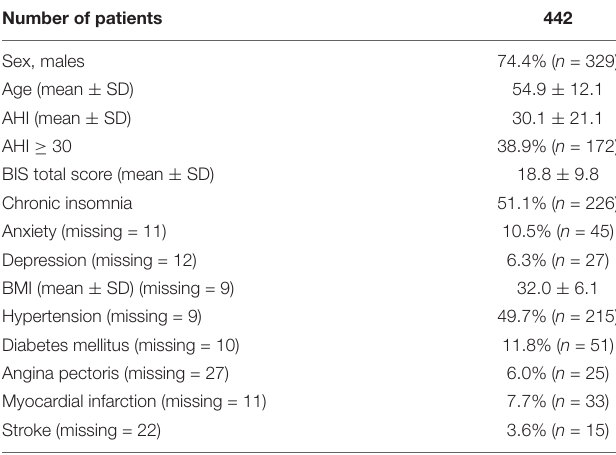
TABLE 1 | Descriptive statistics at baseline among Norwegian patients with obstructive sleep